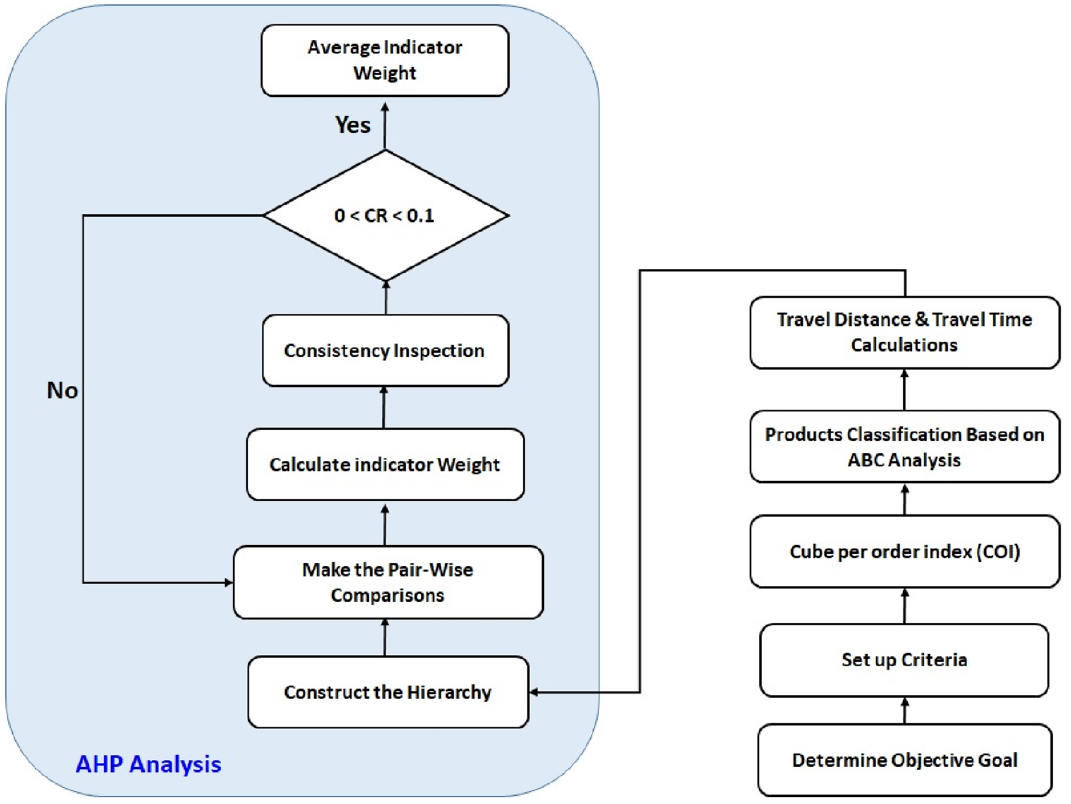
Fig. 3 Methodology steps